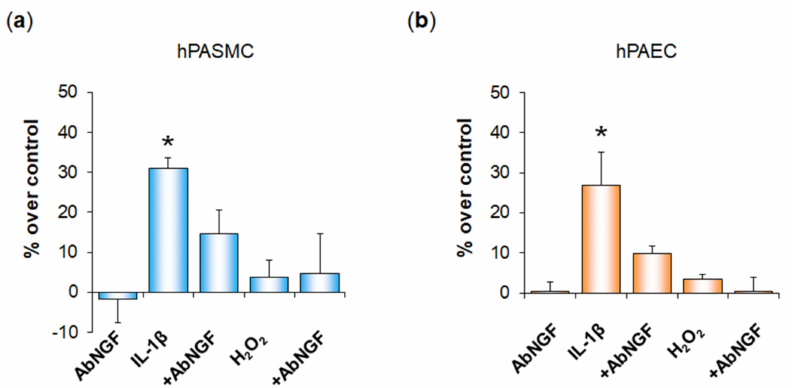
Figure 7. Functional role of NGF secreted by human pulmonary arterial cells after exposure to IL-1 β or H 2 O 2. Proliferation of human pulmonary arterial smooth muscle cells (hPASMC, ( a )) or of human pulmonary arterial endothelial cells (hPAEC, ( b )) was assessed in the absence or presence of interleukin-1 β (IL 1 β , 10 ng/mL, 24 h) or hydrogen peroxide (H 2 O 2 , 10 µ M, 24 h). Cell prolifera- tion was assessed by the colorimetric WST-1 cell proliferation assay. Involvement of NGF in IL-1 β - or H 2 O 2 -altered proliferation of pulmonary arterial cells was investigated through pre-treatment (45 min) with anti-NGF blocking antibodies (AbNGF, 1 µ g/mL). The data are expressed as a percent- age of proliferation compared to untreated control cells (% over control) and are presented as the means ± SD of n = 3 independent experiments performed in triplicate on cells from three control donors. *: p < 0.05 versus untreated control